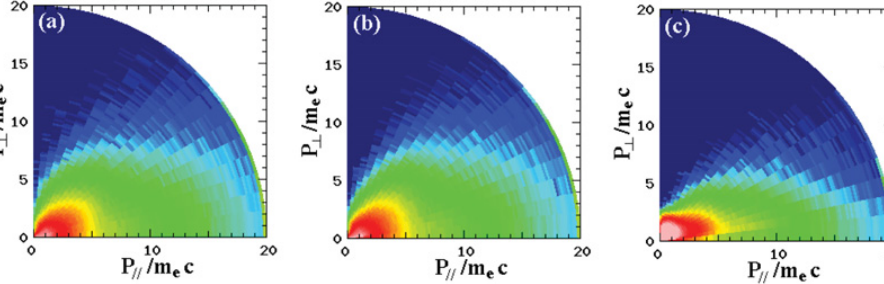
Figure 2. Quasi-static transverse magnetic field profiles at 50 fs for (a) T back = 1, (b) 10 and (c) 100 keV.